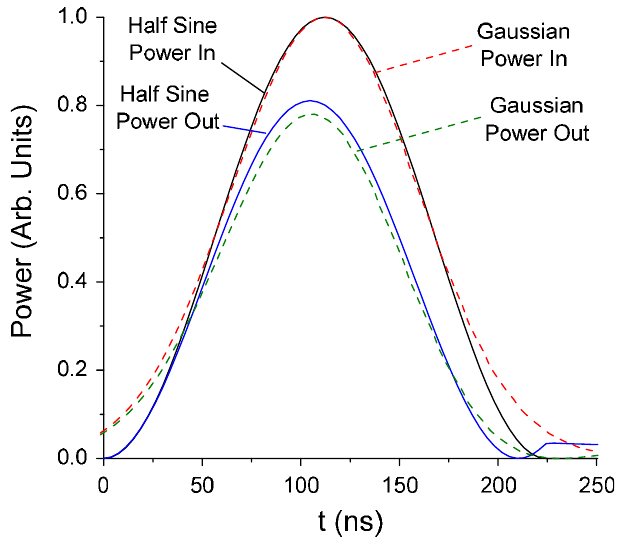
FIG. 9. (Color) The input and output power pulses for the half- sine and Gaussian shapes are compared for design II parameters with an exponential impedance profile.